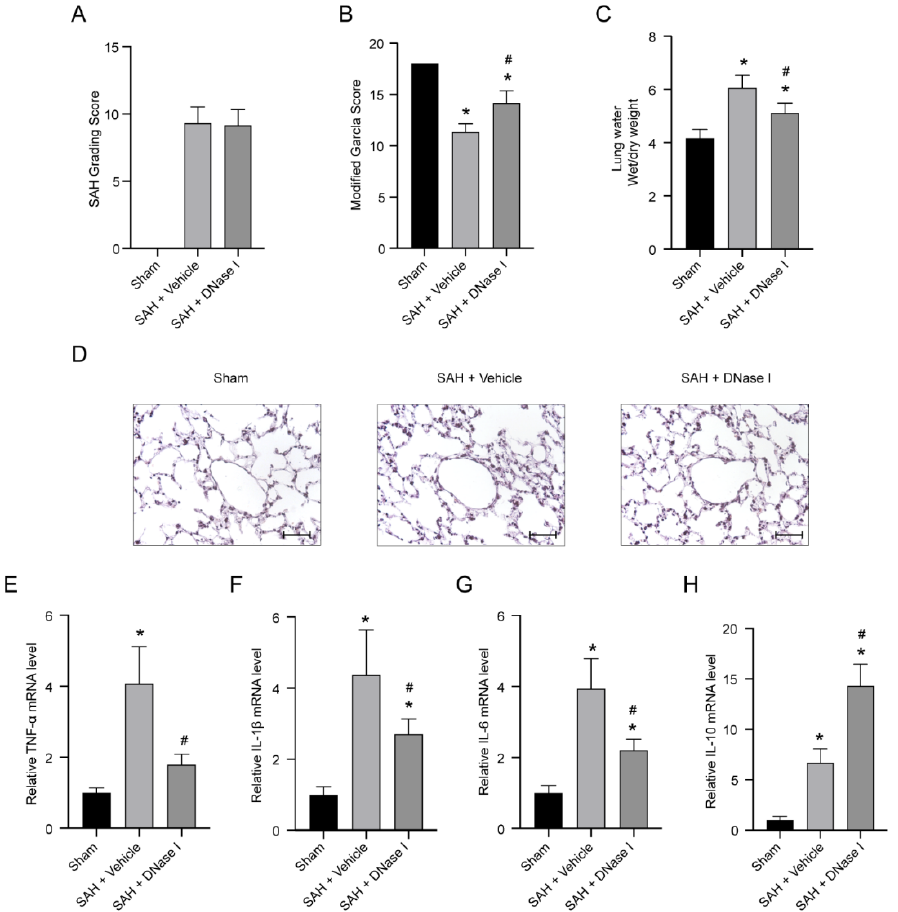
Figure 1. The protective effect of DNase-1 for neurogenic pulmonary edema (NPE) after subarachnoid hemorrhage (SAH). ( A ) The quantification of the SAH grade; n = 18/group. ( B ) The quantification of the modified Garcia scale; n = 18/group. ( C ) Quantification of the lung water; n = 6/group. ( D ) Representative lung histopathology at 24 h after SAH. Scale bar = 50 μ m; n = 5/group. ( E – H ) Quantitative qPCR analysis of the relative expression of TNF- α , IL-1 β , IL-6 and IL-10; n = 5/group. * p < 0.05 versus the sham and # p < 0.05 versus the SAH + vehicle group.